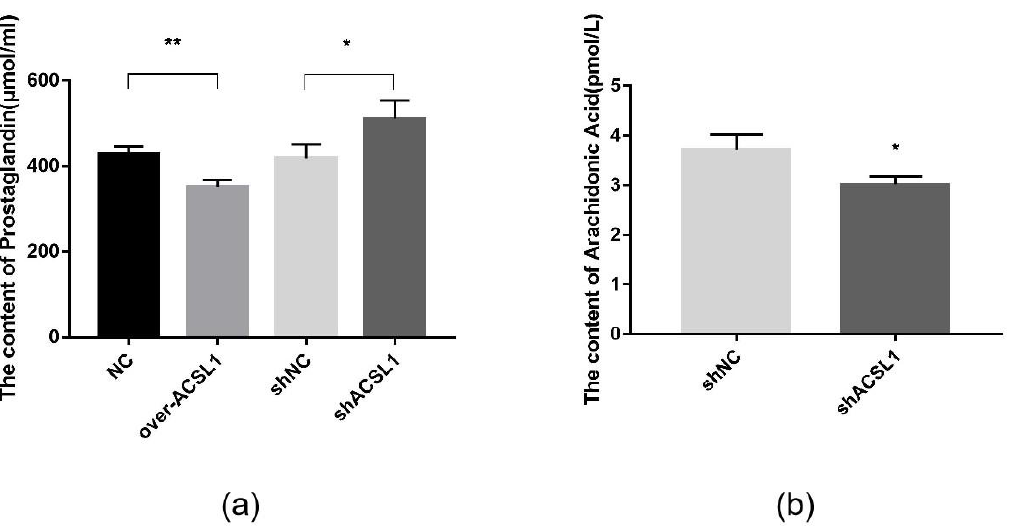
Figure 7. ( a ) The detection of intracellular prostaglandin content (* p < 0.05, ** p < 0.01); ( b ) The detection of intracellular AA content (* p < 0.05). shNC: Adipocytes transfected with shNC as control. shACSL1: Adipocytes transfected with shRNA-1928 of the ACSL1 gene.